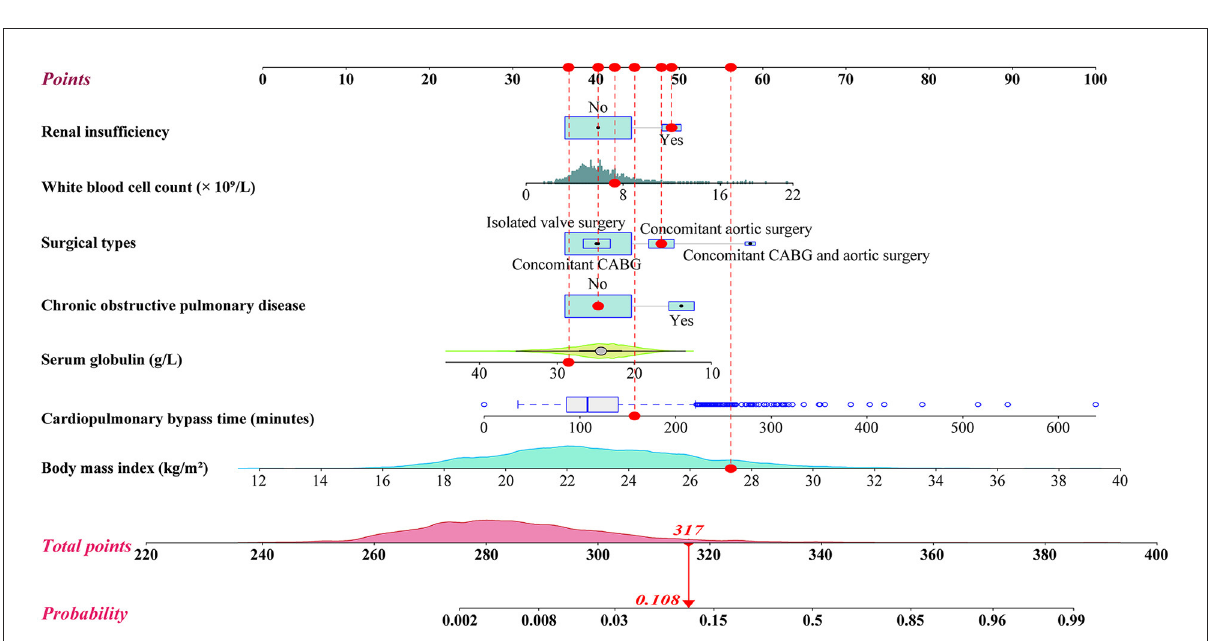
compared to the “treat-all/none” strategies among all threshold probabilities in the training set and among the thresholds of below 0.6 in the validation